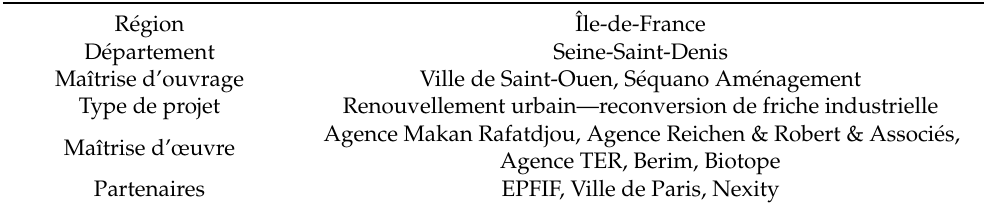
Table 9. Zac des Docks. Source: Authors’ elaboration (2022) based on data from the site http: //www.ecoquartiers.logement.gouv.fr (accessed on 19 June 2022).